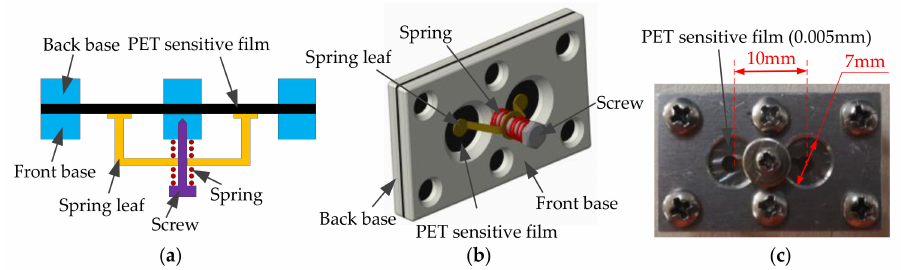
Figure 13. The acoustic-sensitive module based on the inter-membrane bridge bionic structure. ( a ) Plane structure. ( b ) 3D structure. ( c ) Physical photo.